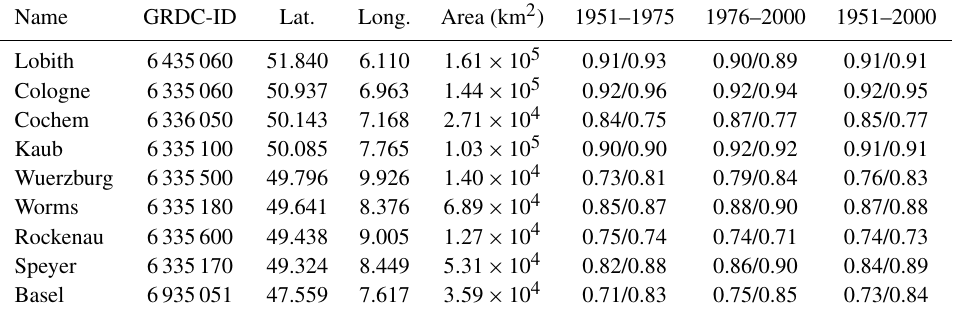
Table 1. River gauges investigated: location (WGS 84), GRDC identification number, catchment area, Nash–Sutcliffe efficiency (NSE) and Kling–Gupta efficiency (KGE) between observed and modelled runoff (NSE/KGE). The model has been calibrated against observation from the three gauges (Lobith, Basel and Cochem) with the NSE as an objective function during